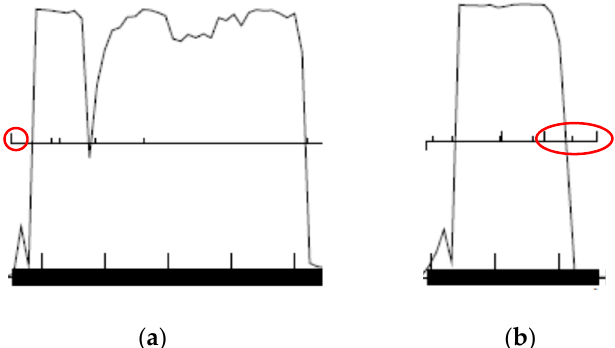
Figure 7. ( a ) The gene on the left, transcribed from left to right, has six start codons (upward ticks above the midline in the figure). Of these, only the leftmost one, circled in red, includes all of the gene’s coding potential, as it is located upstream of the coding potential plateau; ( b ) the gene on the right, transcribed from right to left, has eight start codons. Of these, the rightmost three, circled in red, include all the coding potential, while the remaining five do not. When deciding, only the plateau in coding potential counts, not the slope.